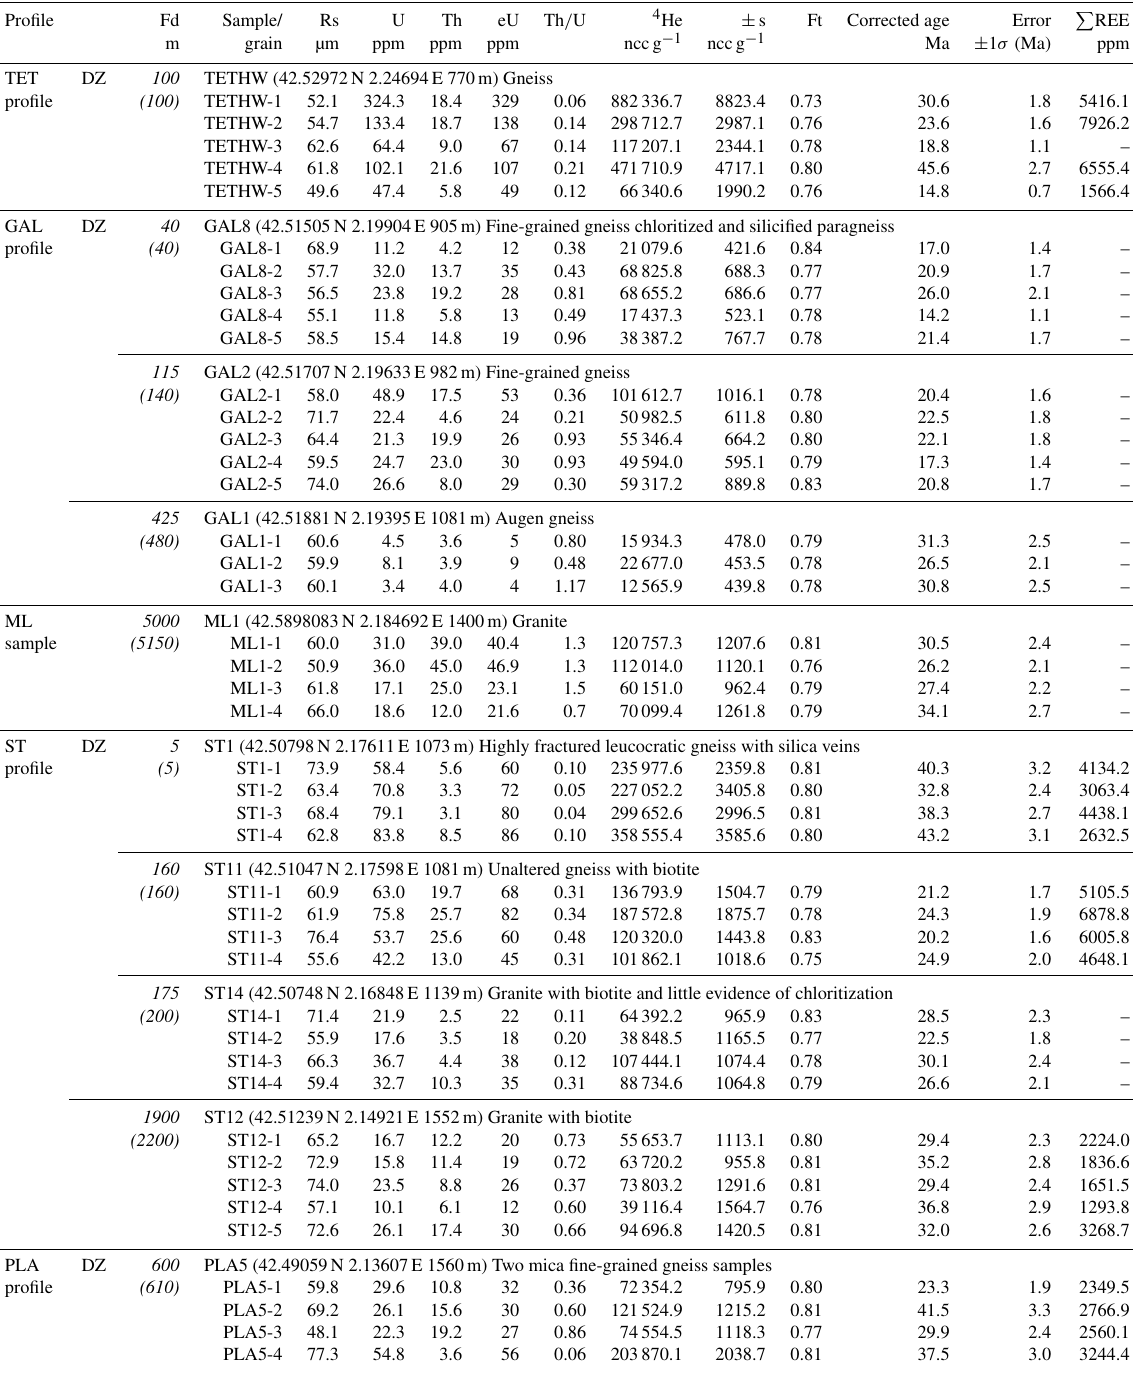
Table 2. AHe ages of hanging-wall